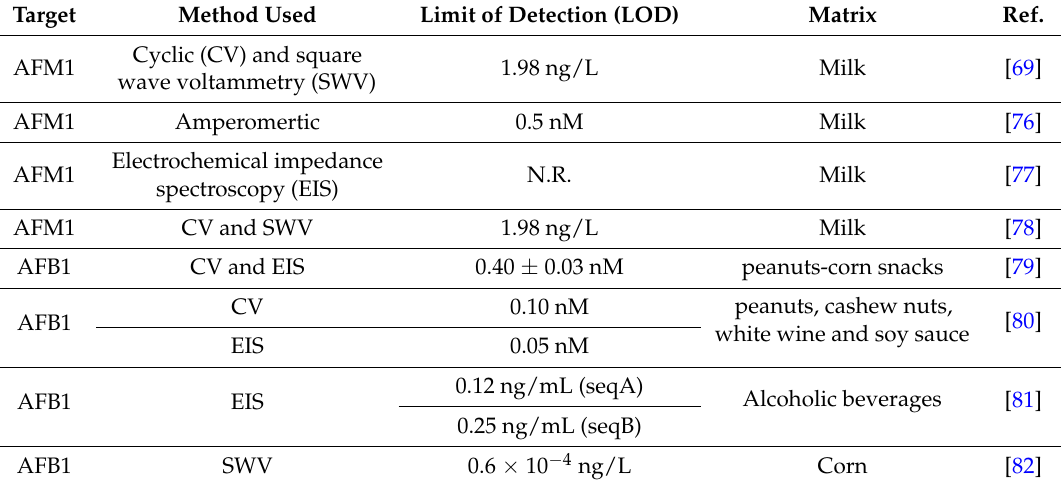
Table 4. The reported literature based on electrochemical aptasensors for detection of